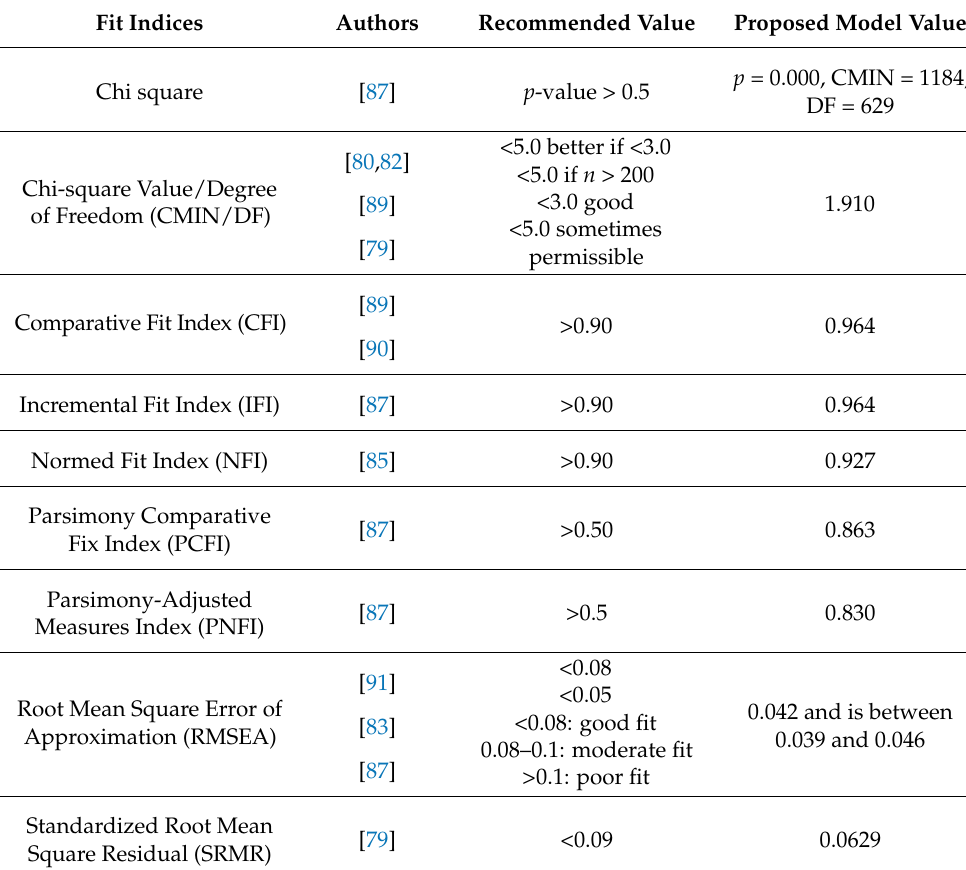
Table 6. Goodness-of-fit statistics for measurement